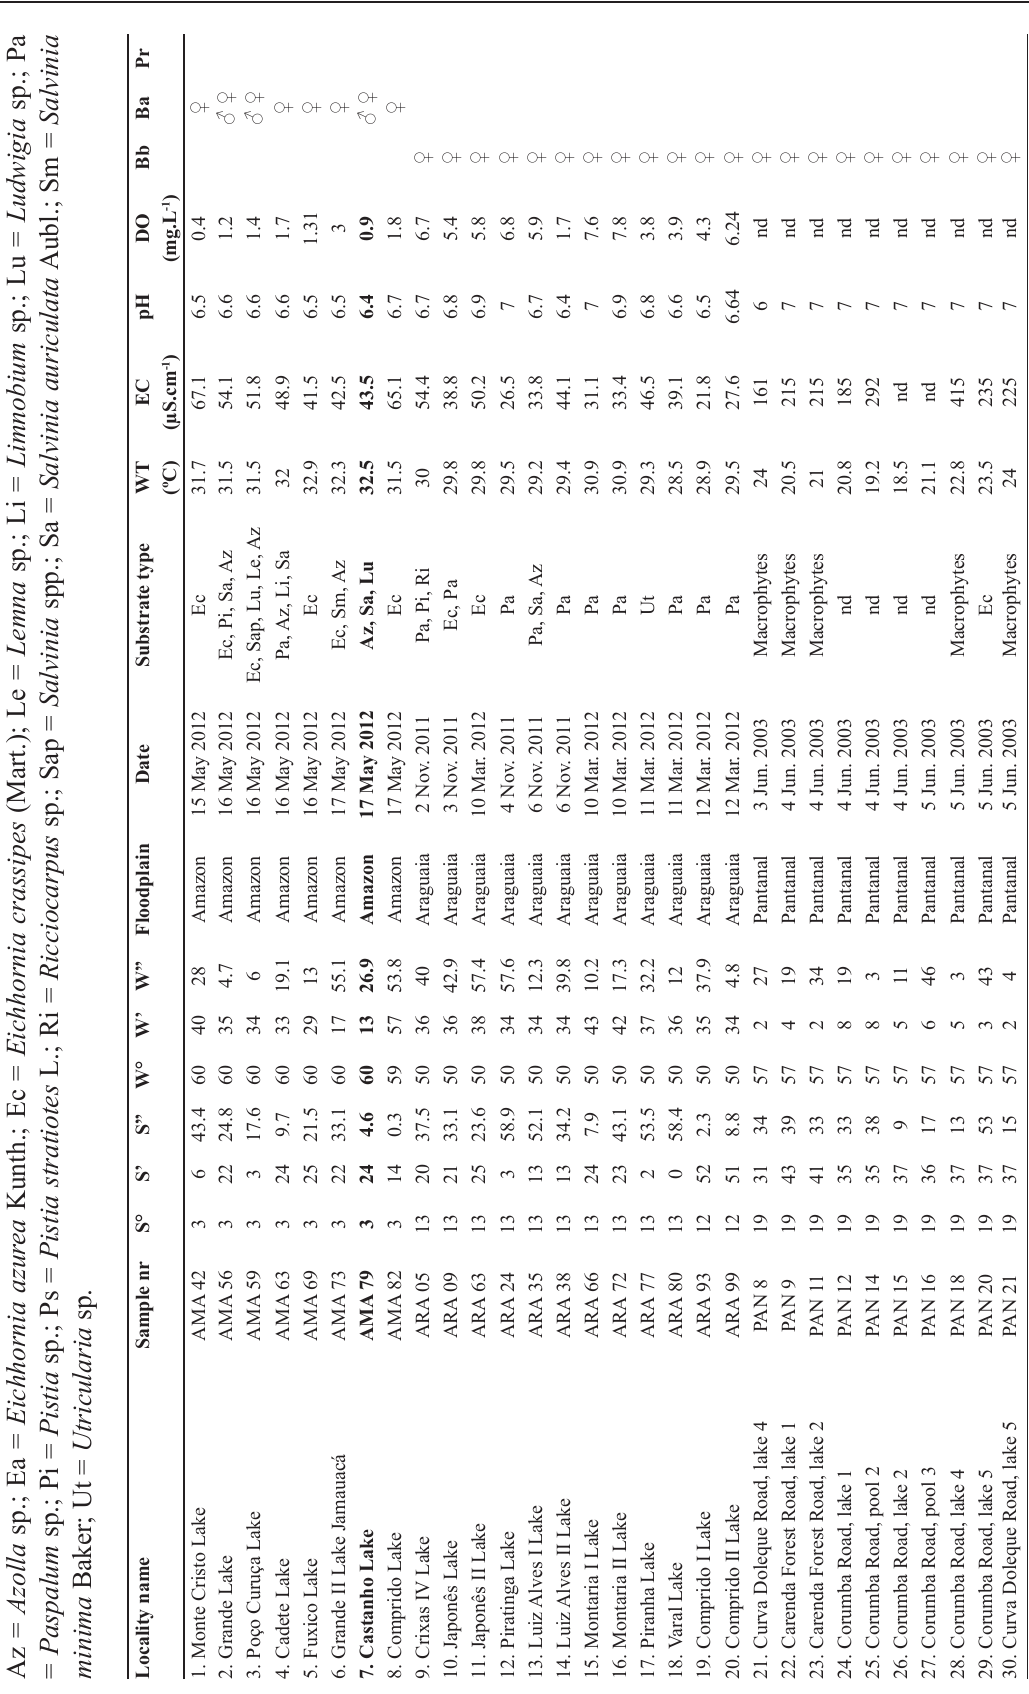
nd n ; e oxyg d e y ; it ondu